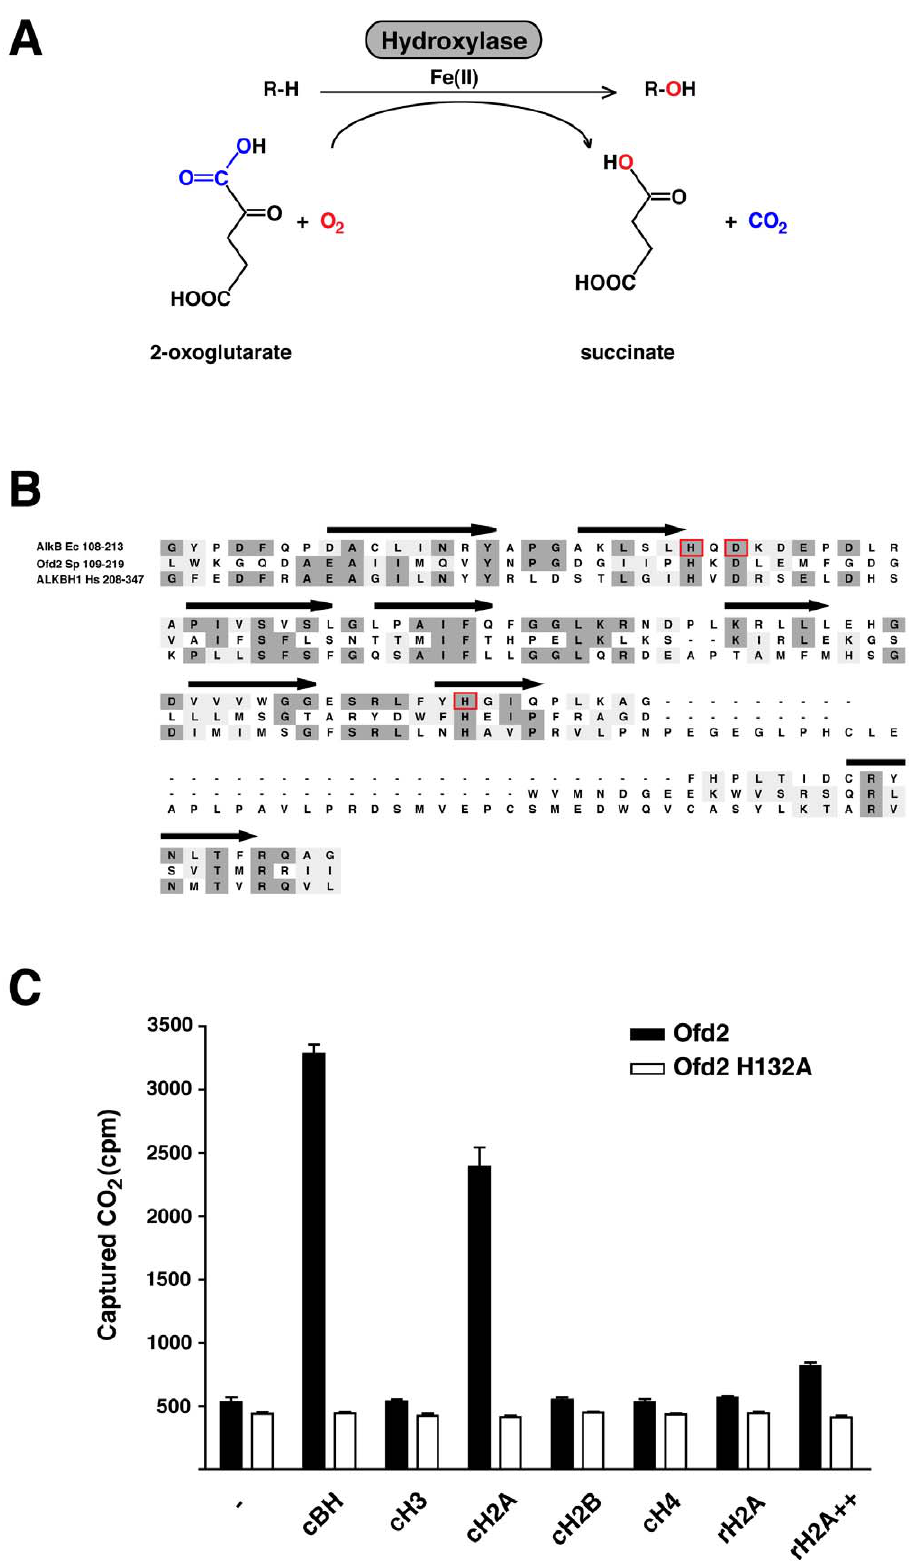
Figure 1. Histone H2A dioxygenase activity. A) General reaction schematic for 2-OG-Fe(II) hydroxylases. R represents an amino acid sidechain. B) ClustalW sequence alignmant of AlkB, Ofd2 and ALKBH1. The secondary structure B-strands for AlkB are dipicted as arrows. Residues in AlkB involved in iron binding are boxed in red. Dark and light shading denote conserved and similar residues respectively. Species abbreviations: Ec Escherichia.coli ; Sp Schizosaccharomyces pombe ; Hs Homo sapiens . C) Dioxygenase assay of Ofd2 and Ofd2 H132A iron binding mutant. Calf thymus bulk histone (cBH)